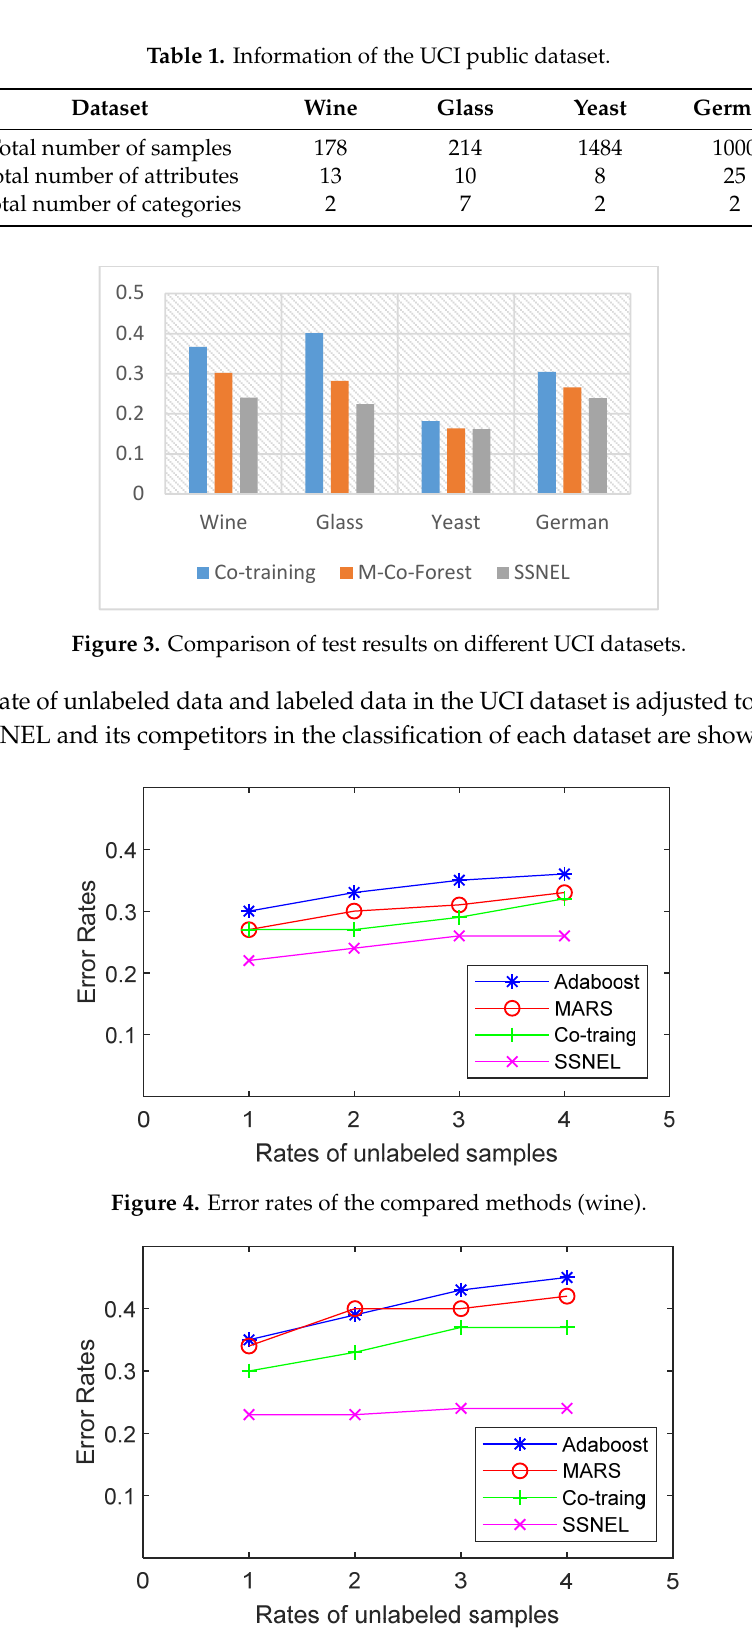
Table 1. Information of the UCI public dataset.